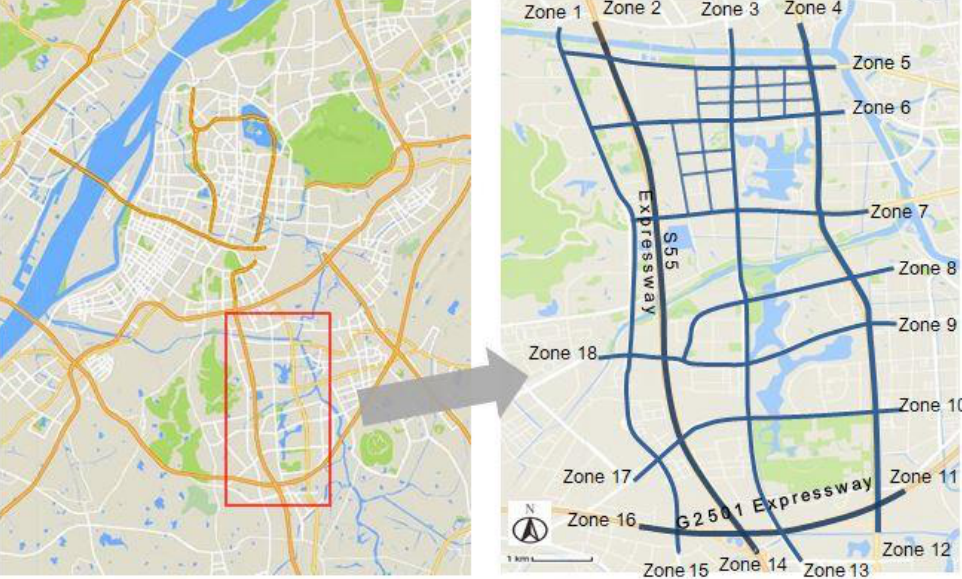
Study area of the city of Nanjing, China Simulation model